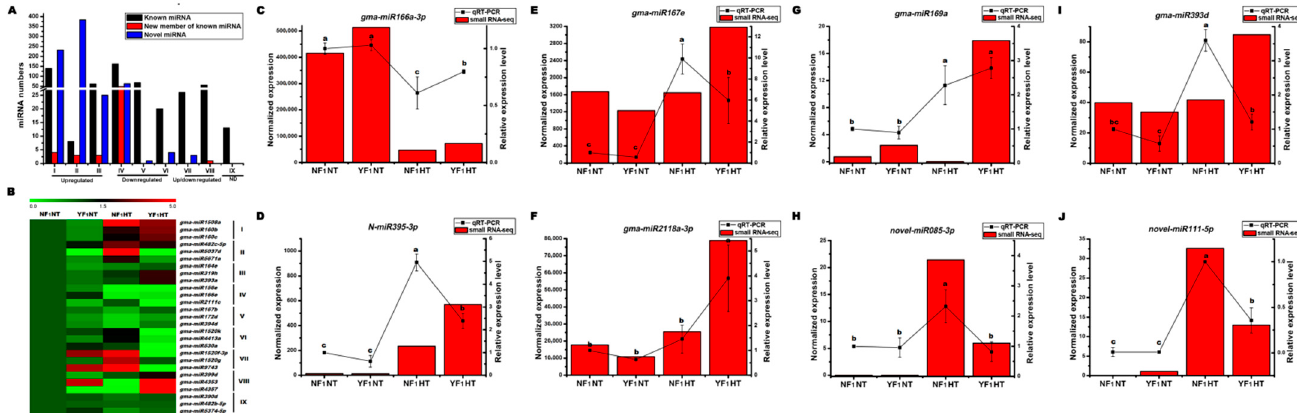
Figure 2. Identification and quantitative real time PCR (qRT-PCR) analysis of HT-responsive miRNAs in the flower bud of soybean CMS-based F 1 under HT stress. ( A , B ) Quantity distribution and heat map of HT-responsive microRNAs (miRNAs). ( C – J ) qRT-PCR verification of HT-responsive miRNAs. Data are presented as means ± standard deviation (SD) from three independent biological replicates. Values with a different letter indicates statistical differences (one-way ANOVA, Duncan’s test, p < 0.05). The left and right y -axes are the expression level scales for sRNA-seq and qRT-PCR analysis, respectively.